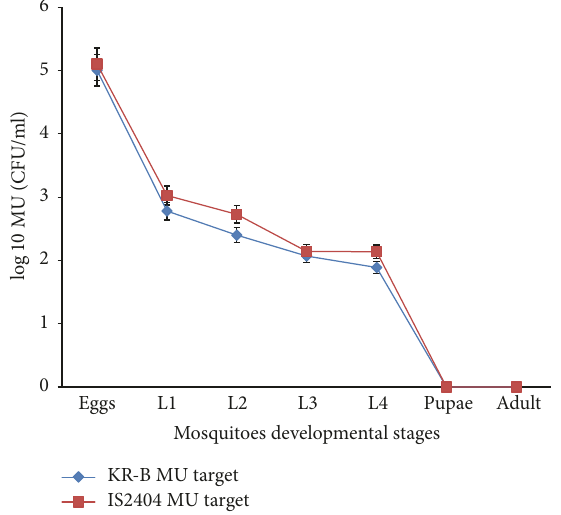
Figure 2: Distribution of average bacterial load during mosquito developmental stages. L1, L2, L3, and L4 correspond to first, second, third, and fourth instars larvae, respectively. Values are given with error bars at